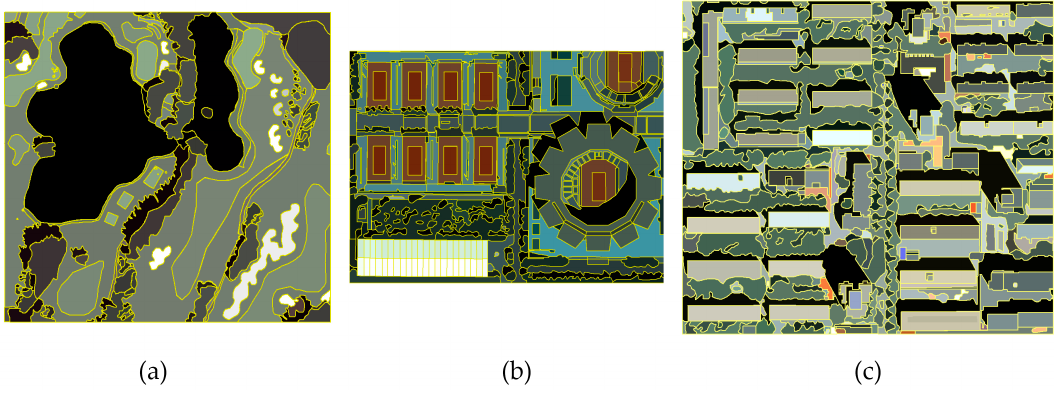
Figure 6. The ground truth of subscenes: T1 ( a ); T2 ( b ); and T3 ( c ). The reference segmentation boundaries are delineated by yellow lines. The values of objects in the ground truth are the mean value of the reference segments of original images.